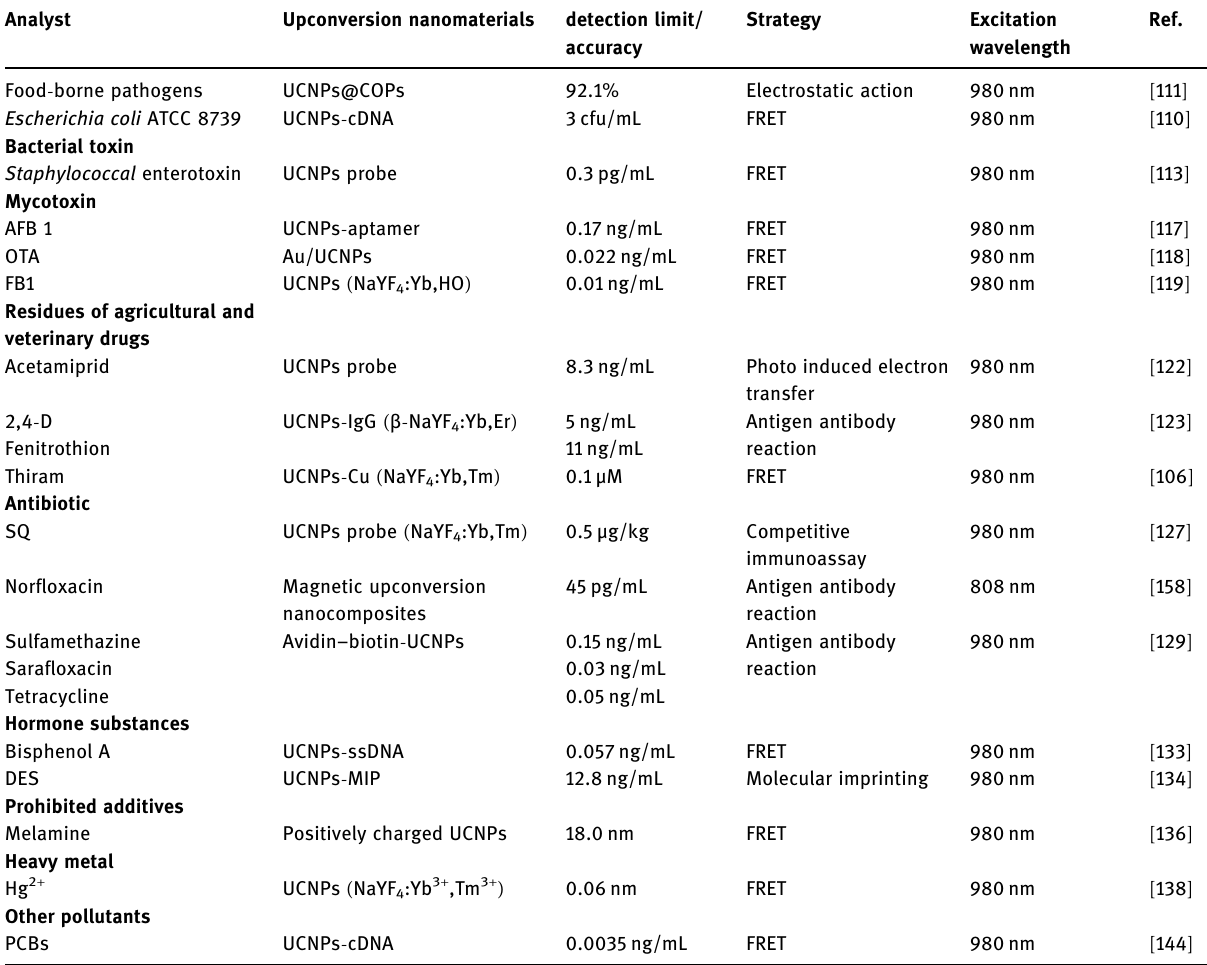
Table 2: Application of UCNPs in food safety detection